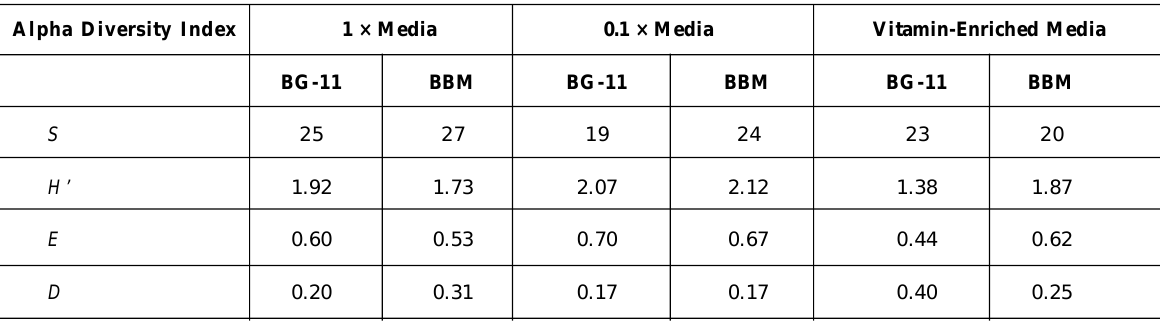
Table 4: Diversity indices of algal population grown on six different media Alpha Diversity